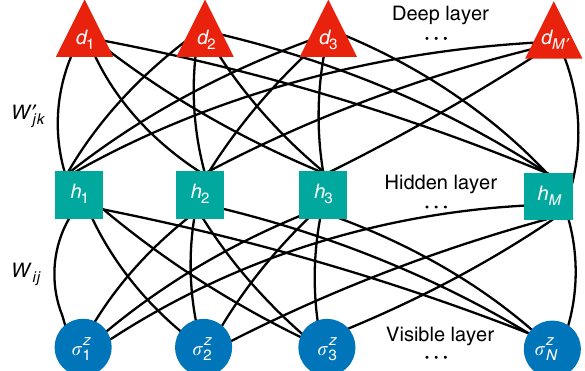
Fig. 1 Structure of deep Boltzmann machine. Dots, squares, and triangles (cid:5) (cid:6) represent physical degrees of freedom σ z i , hidden units ( h j ), deep units ( d k ), respectively. Solid curves represent interlayer couplings ( W ij and W ′ jk